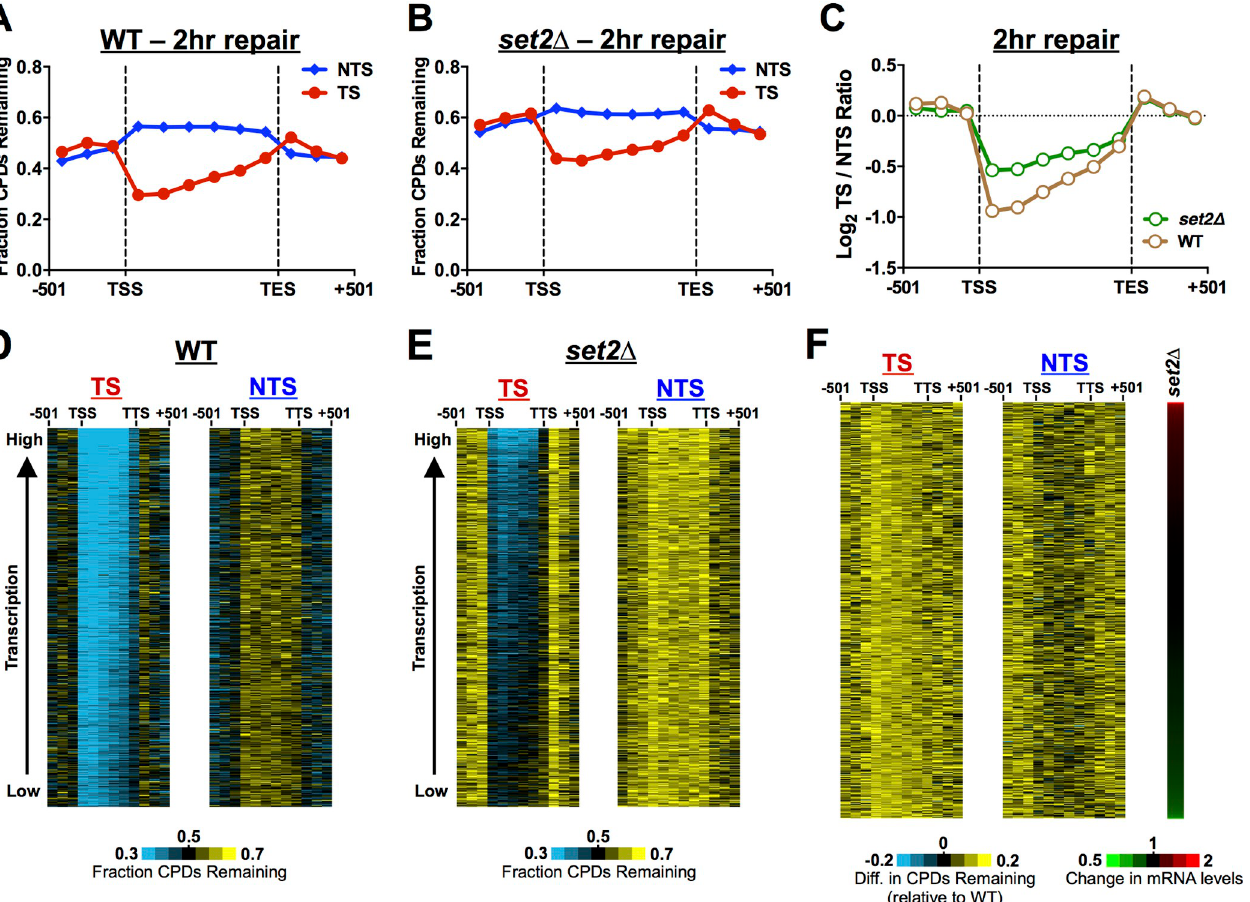
Fig 2. CPD-seq analysis of genome-wide repair of set2 Δ mutant cells reveals a defect in TC-NER. (A) The average fraction of CPDs remaining after 2 hours (2hr) of repair was plotted from the CPD-seq data for both the transcribed strand (TS) and non-transcribed strand (NTS) for approximately 5000 yeast genes in WT cells. Number of unrepaired CPDs after 2hr was normalized to the initial CPD levels (0hr) to calculate the fraction of CPDs remaining. CPD-seq data for each gene was divided into 6 equally sized bins and the fraction of CPDs remaining was analyzed in each bin. The fraction of CPDs remaining was also analyzed for 3 bins each consisting of 167 bp of flanking DNA upstream of transcription start site (TSS) or downstream of transcription end site (TES) for each gene. CPD-seq data was scaled using the overall repair data for the 2hr time point from alkaline gel analysis (Fig 1G). (B) Same as panel A , except for set2 Δ cells. (C) The log 2 ratio of unrepaired CPDs on the TS relative to the NTS in the WT and set2 Δ cells is shown to quantify the TC-NER defect in set2 Δ cells. Less efficient repair of the TS by TC-NER in set2 Δ cells is indicated by the log 2 TS/NTS being closer to zero. (D,E) Gene plot analysis of WT and set2 Δ cells to examine CPD repair within genes throughout the yeast genome. The fraction of CPDs remaining following 2hr of repair (relative to 0hr) is plotted for 6 equally sized bins comprising the transcribed region of each gene, for both the TS and NTS. 3 bins consisting of 167 bp regions upstream of TSS and 3 bins downstream of the TES are also depicted. Genes were ordered based on transcription frequency [42]. ( F ) Same as panels D,E , except showing difference in the fraction of unrepaired CPDs at the 2hr time point in set2 Δ mutant cells relative to WT. Genes are ordered by their fold-change in mRNA levels in the set2 Δ mutant (right panel). mRNA expression data for set2 Δ is from